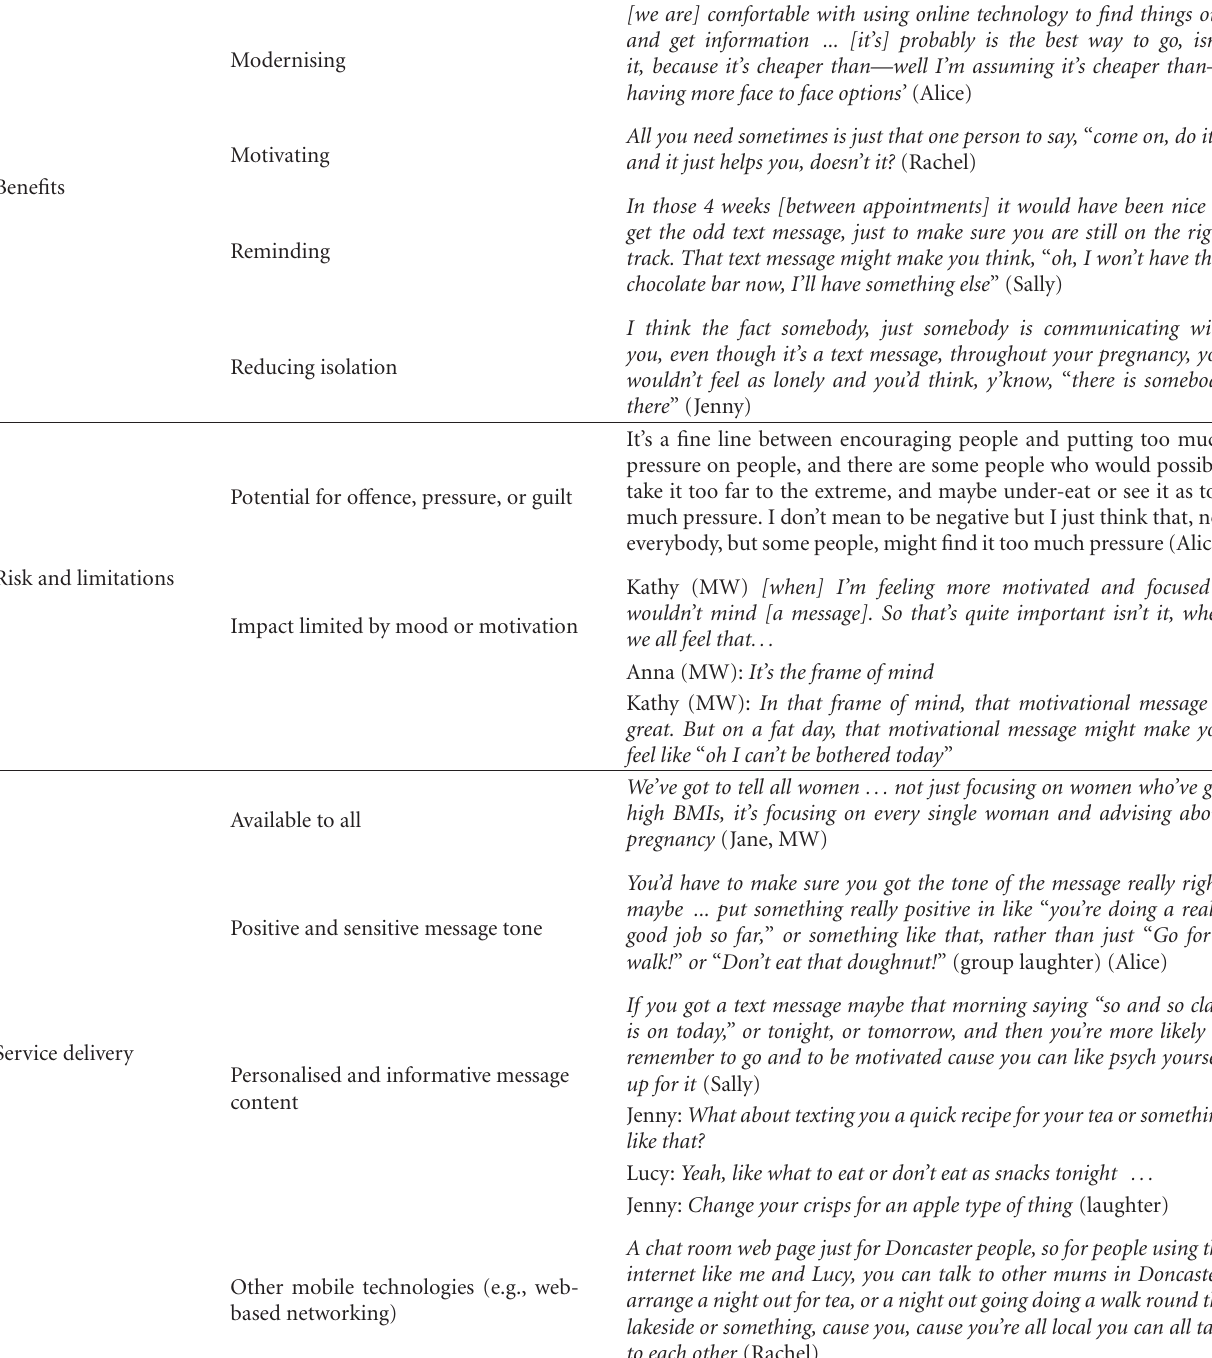
Table 1: Results from the first focus group of women and midwives on the use of text messaging services in support of maternal obesity